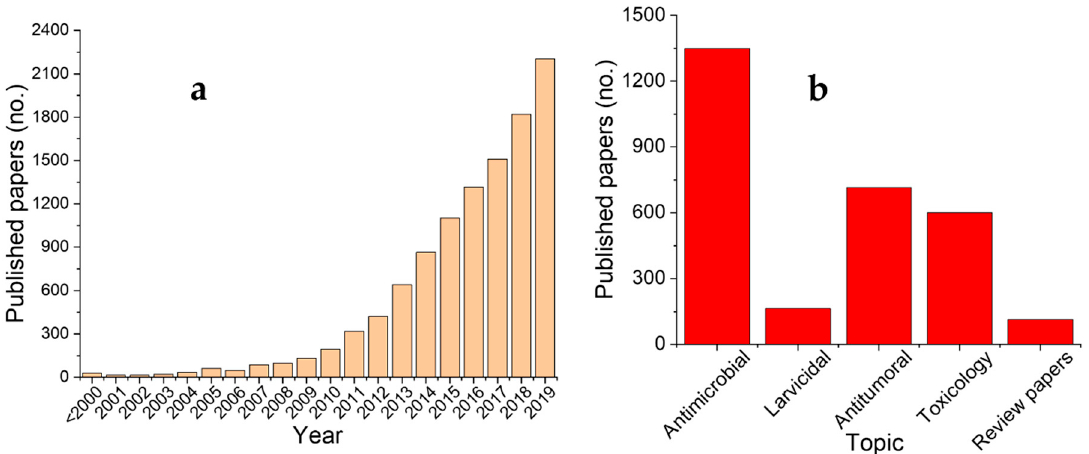
Figure 1. Published papers on the topic of the current review. ( a ) Studies on the general topic of nanoparticles phytosynthesis and ( b ) studies on the selected topics, both published in 2019. The relatively high number of papers published on the topic “toxicity” was due to the overlapping of other applications (antimicrobial and antitumoral) and due to keywords/abstract description provided by the authors.